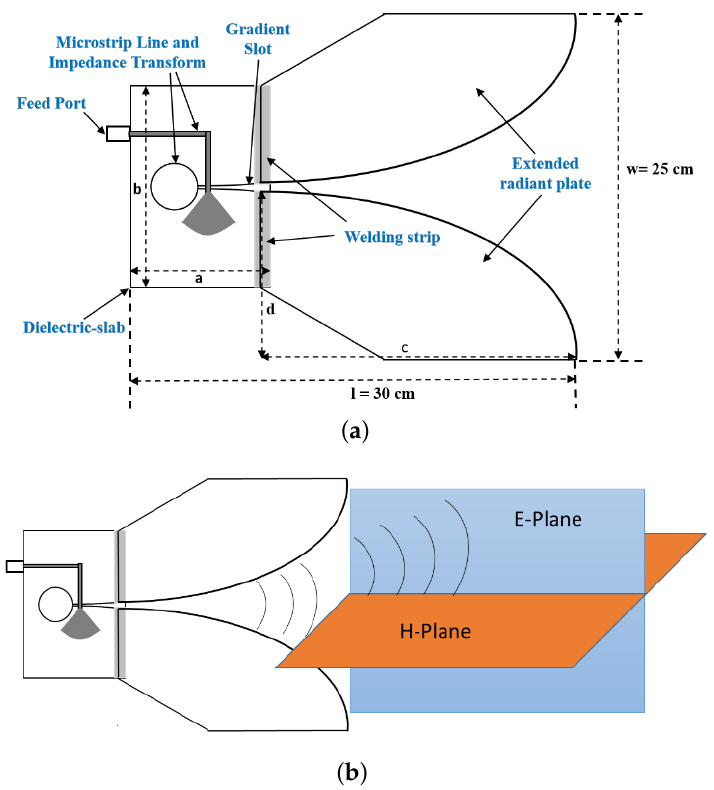
Figure 2. The ultra-wideband Vivaldi antennas. ( a ) The schematic of antennas with the total length of 30 cm and the total width of 25 cm. ( b ) The field structure of the antennas, where the electric field plane is parallel to the antenna plane, and the magnetic field plane is perpendicular to it.